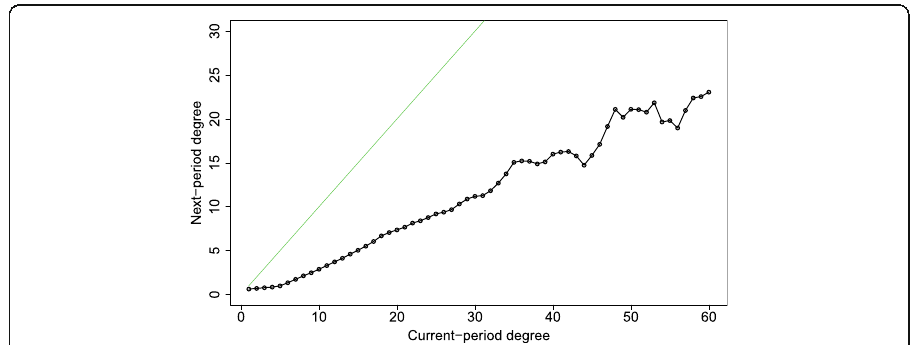
Fig. 4 The expected next-period degree (Y-axis) as a function of the current-period degree (X-axis) is marked by the black dotted line. The next-period expected degree was calculated per current-period degree using the respective column in the transition matrix (Fig. 3). The green line marks the stability reference - when the expected next-period degree is equal to the current-period